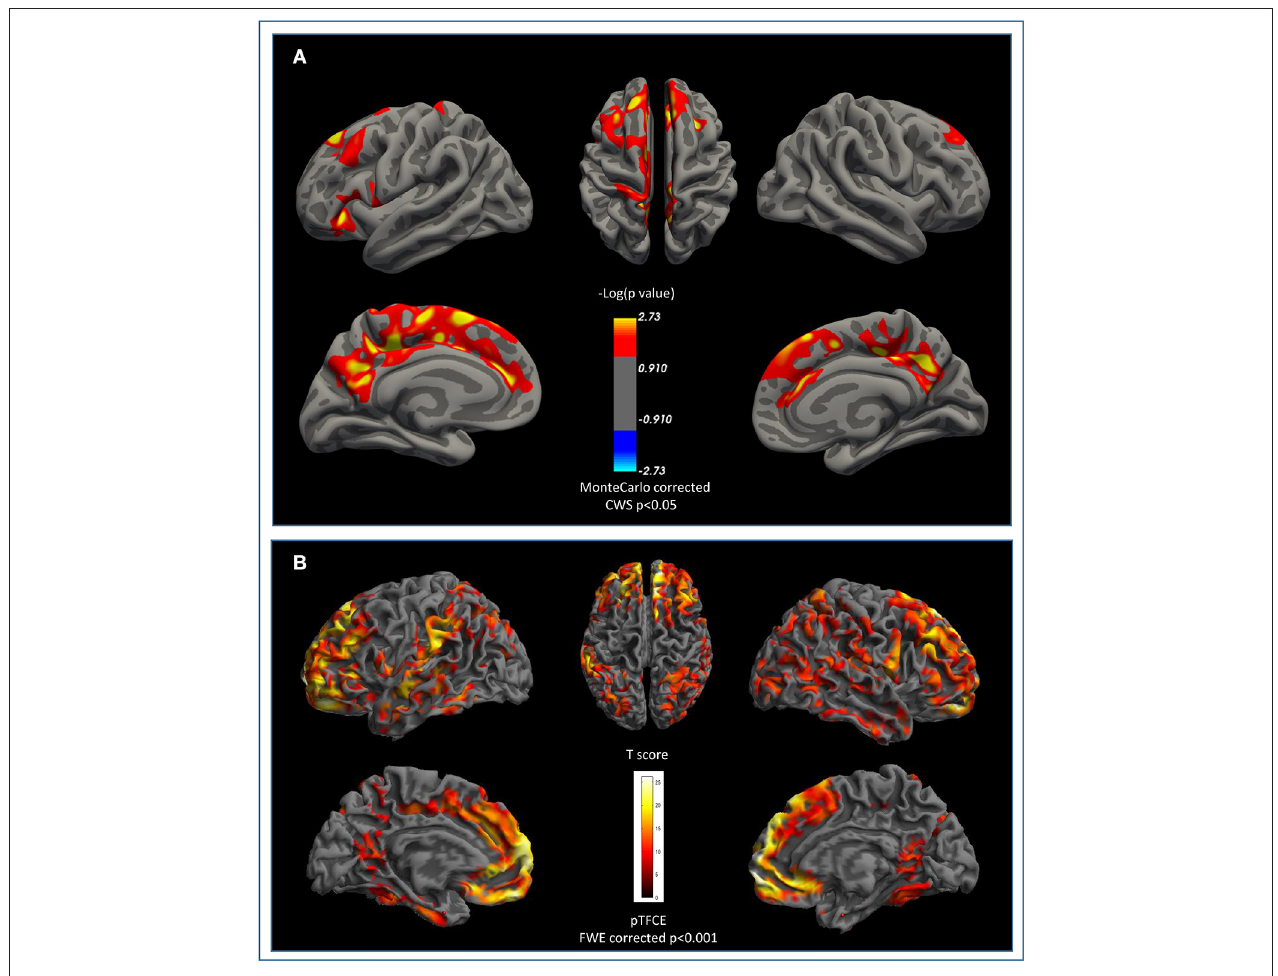
FIGURE 1 | β -Amyloid cortical deposition and brain atrophy in PD-MCI. (A) Surface based comparison between standardized uptake value ratios (SUVR) in PD-MCI-A β + vs. A β -. Areas that survived a cluster-wise Monte-Carlo correction ( p < 0.05) adjusted for two-hemispheres are displayed. Cerebellum cortex was used as reference region for partial volume correction. (B) Shared pattern of atrophy between PD-MCI-A β + vs. A β - compared to healthy matched population at FWE pTFCE p < 0.001. No areas survived after β -amyloid + /– at TFCE uncorrected p < 0.001 threshold. FWE, family-wise error; TFCE, Threshold-Free Cluster Enhancement.